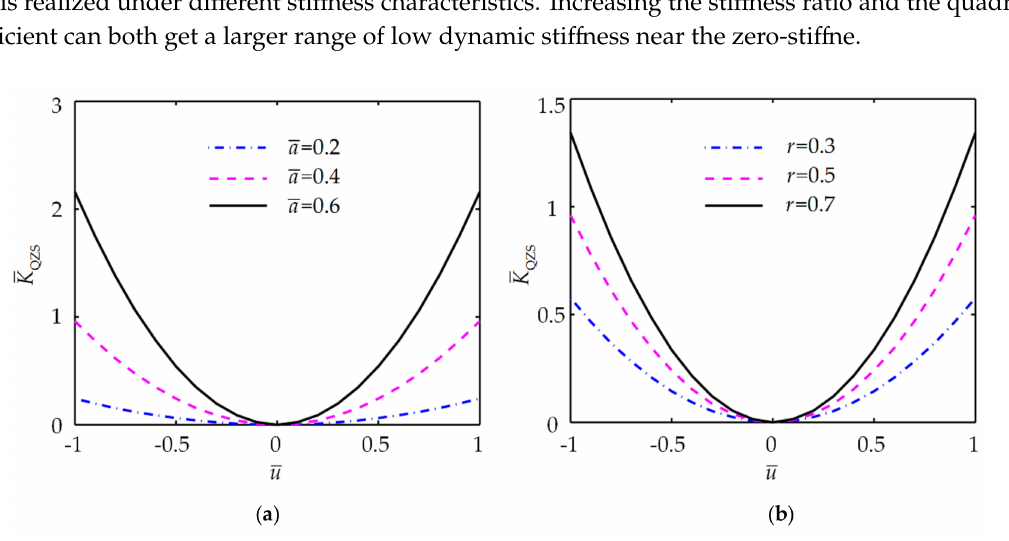
Figure 7. Non-dimensional sti ff ness characteristics of QZS vibration isolator. ( a ) r = 0.5; ( b ) a =